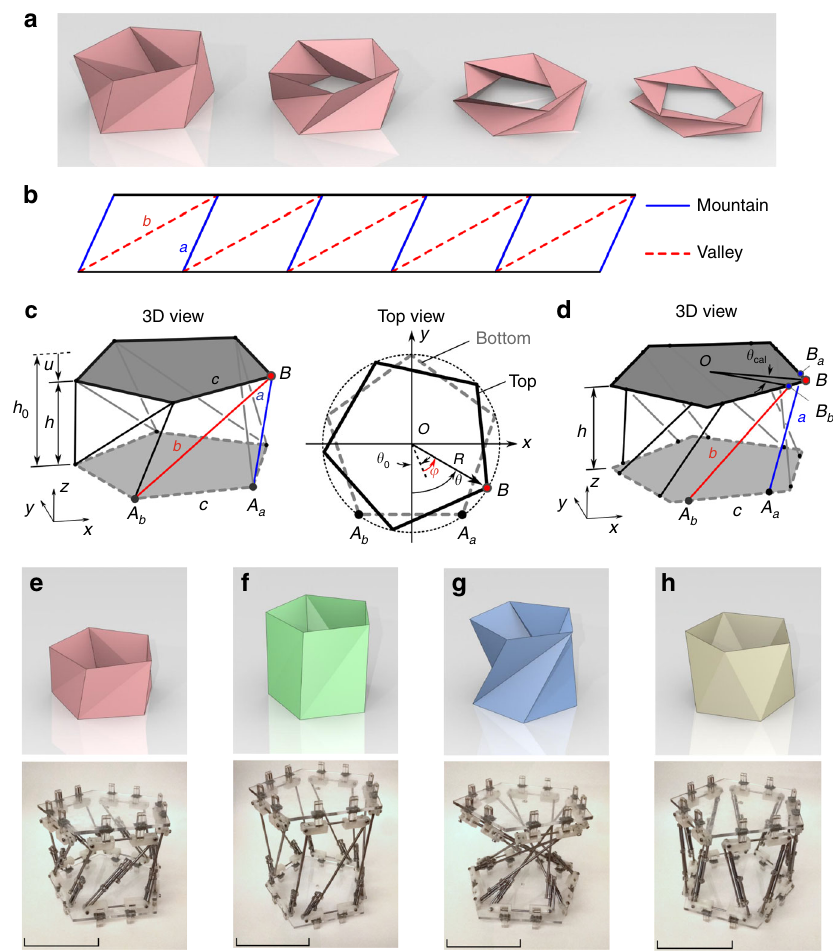
Fig. 1 Geometry of triangulated cylindrical origami (TCO). a Folding motion of the TCO. b The fl at sheet with crease patterns consisting of mountain crease lines ( a shown as blue solid lines ) and valley crease lines ( b shown as red dashed lines ). c Truss version of the TCO, where all facets are removed and crease lines are replaced by linear springs with a spring constant of k . d Modi fi ed truss structure for the fabrication of physical prototypes. e – h Graphical illustrations of four different TCO con fi gurations (upper row) and digital images of their physical prototypes ( lower row ) ( scale bar 100 mm). Their initial con fi gurations are ( h 0 , θ 0 ) = (90 mm, 46°), (150 mm, 40°), (140 mm, 92°), and (119 mm, 0°) from left to